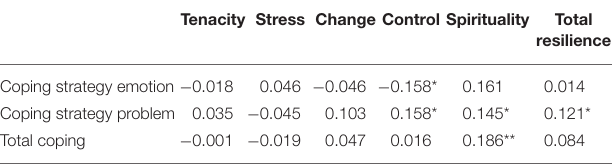
Table 3 | Bivariate correlations between resilience and coping